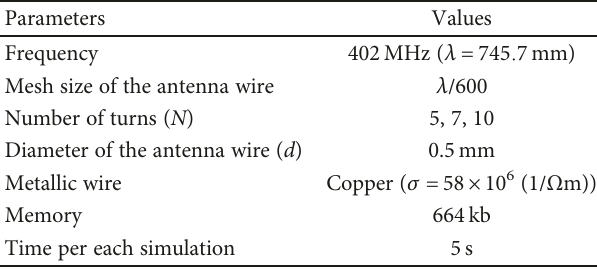
Table 2: Simulation parameter of NMHA in free